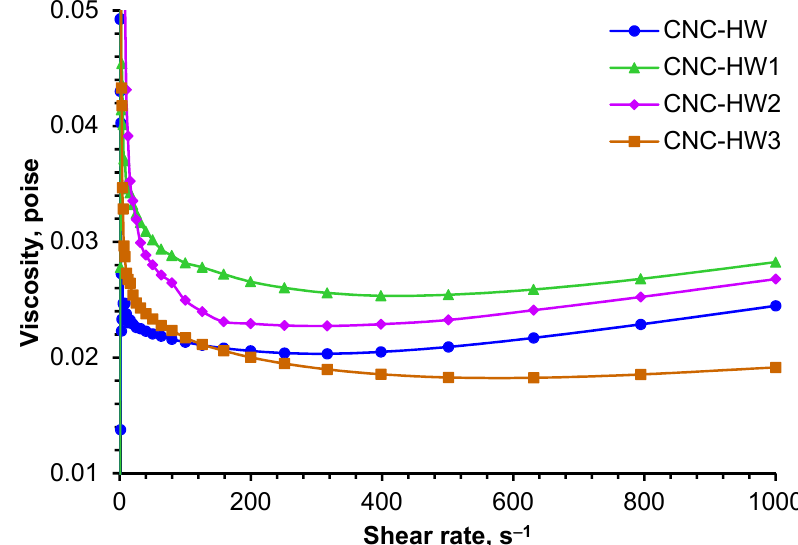
Figure 7. Viscosity measurements of CNC from HW and oxidized HW.